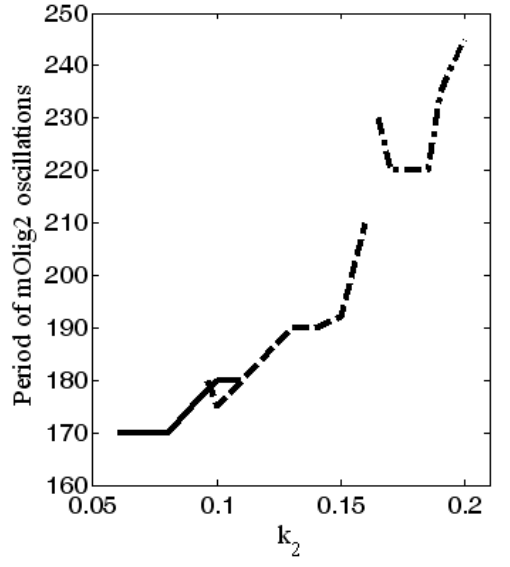
Figure 5. Amplitude of the oscillations as a function of the values of